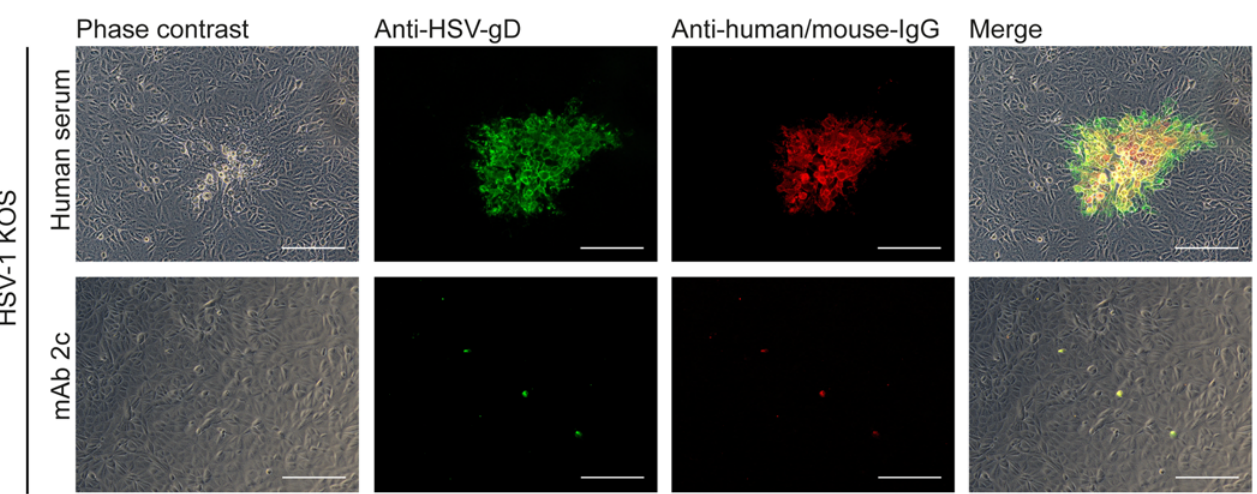
Figure 1. MAb 2c effectively blocks cell-to-cell spread of HSV-1 KOS. Confluent Vero cells were infected with 100 TCID 50 of HSV-1 KOS and treated with either pooled human polyclonal HSV-neutralizing sera (1:40 in medium) or mAb 2c (500 nM). Cells were stained 48 h after infection for viral transmission with an HSV-1/2-glycoprotein D specific murine antibody and an Alexa488-conjugated secondary anti-mouse or anti-human antibody. Bound human antibodies or mAb 2c were detected with a Cy3-conjugated secondary antibody. Uninfected cells served as negative controls and showed no background staining (not shown). Magnification: 100x. Scale bar: 100 μ